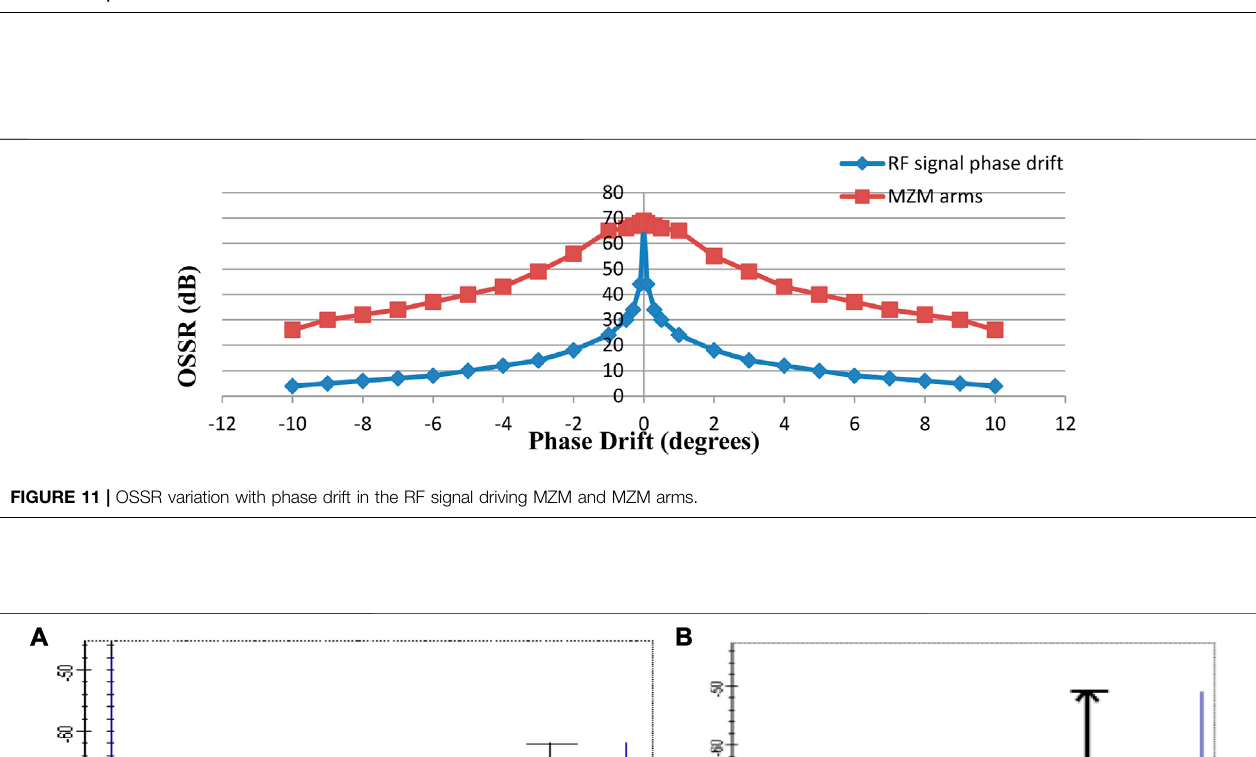
fi ber. The impact of using a cascaded ampli fi er con fi guration having EDFA 1 connected with optical ampli fi er with their parameters mentioned in Table 2 enhances the RFSSR by 11 dB in comparison to a single ampli fi er con fi guration with a